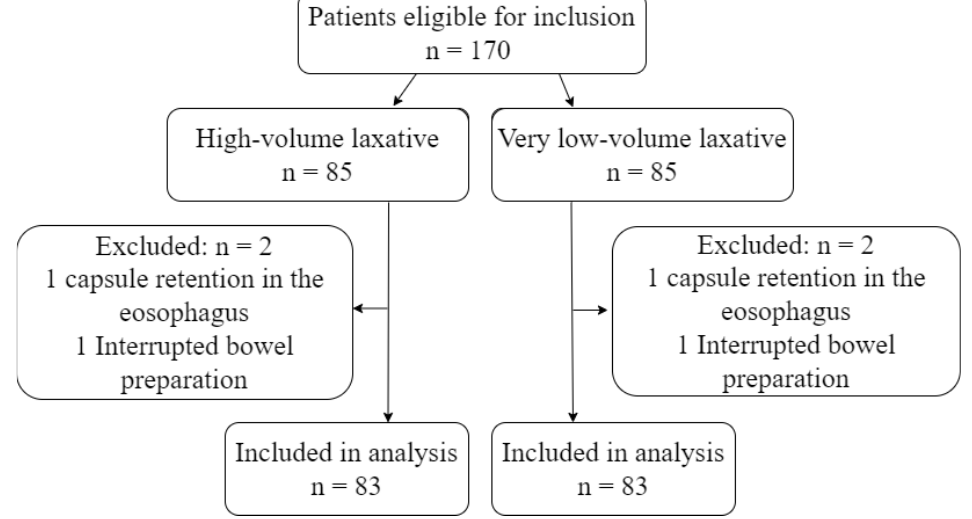
Figure 2. Flowchart. Table 2. Baseline information.